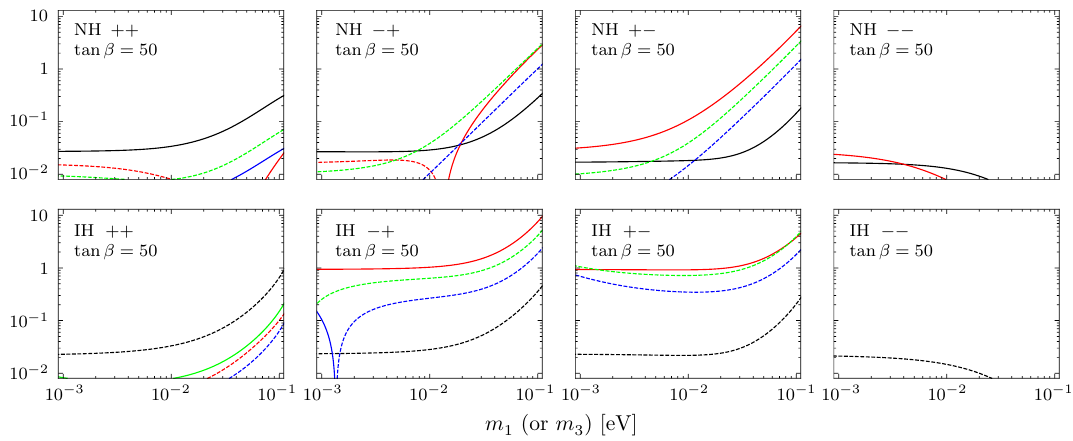
(or m ) in the NH (or 1 3